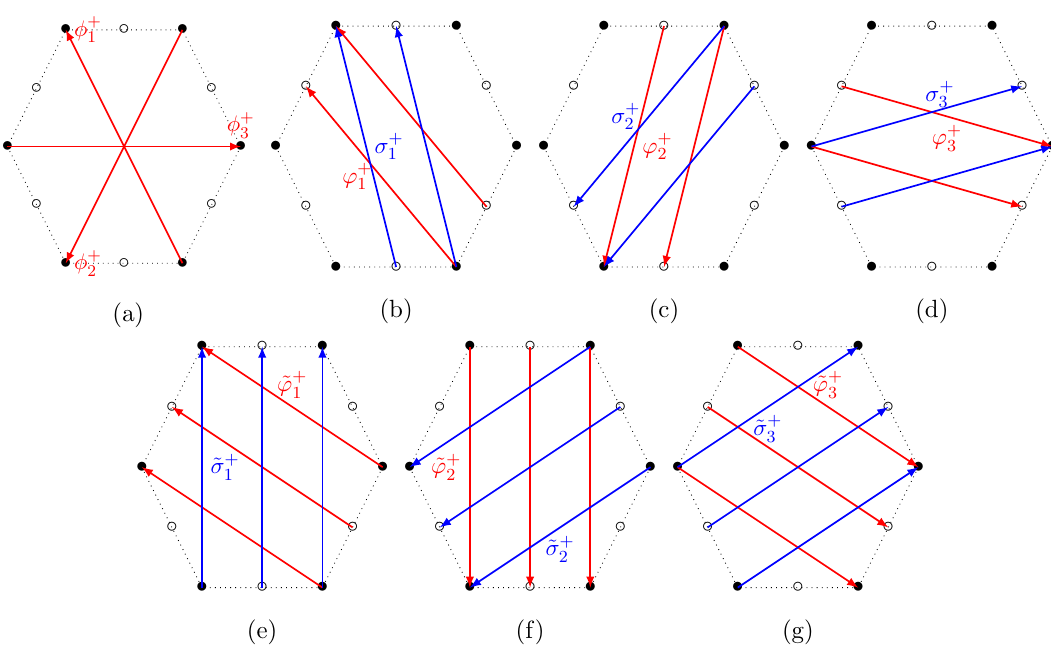
Figure 20. The rank one, two, and three regular zero modes for the C [(2 ; 2)] brane, exemplifying the ( N; N ) case. The maximal Higgs (cid:30) + of (a) connect extremal weight states. The next-to-maximal i Higgs ’ + , (cid:27) + of (b){(d) also relate extremal and non-extremal weight states. Neither the rank i i